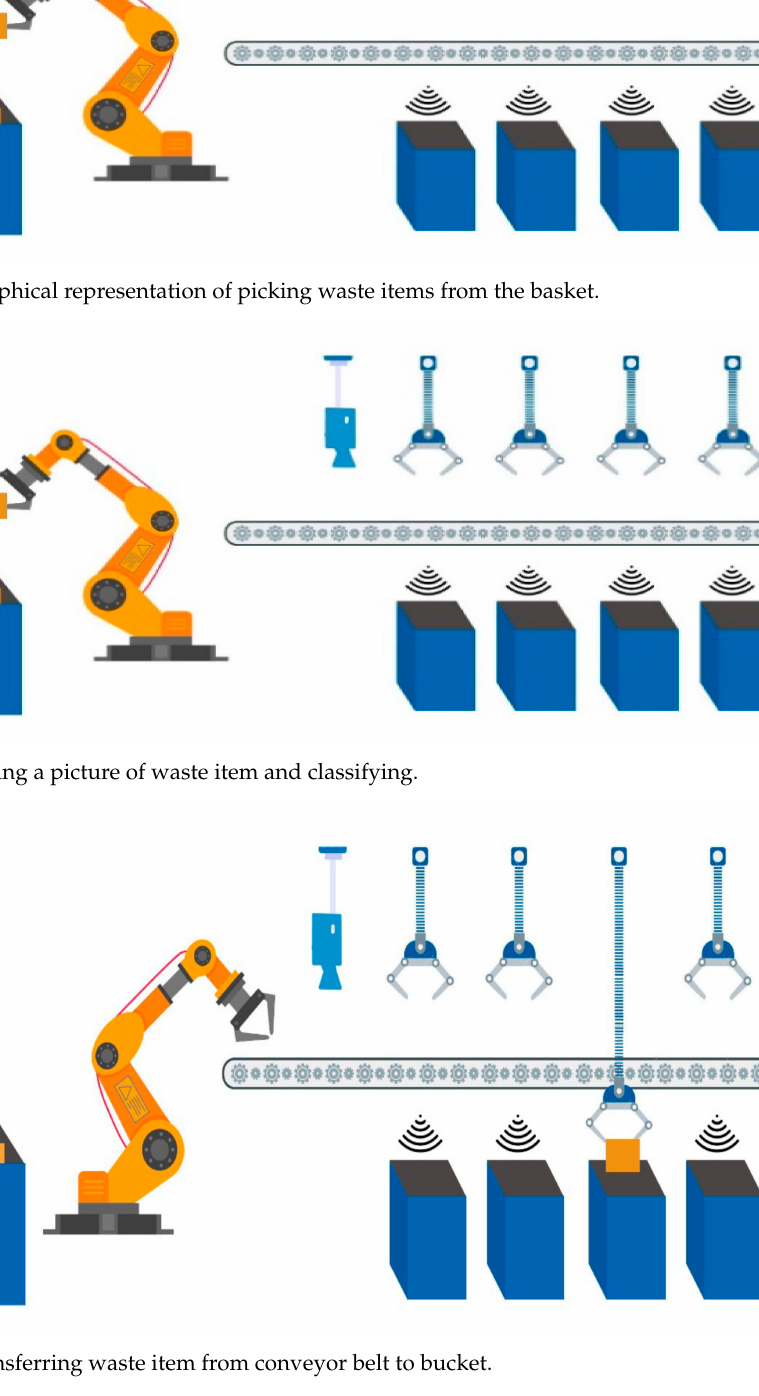
Figure 3. Transferring waste item from conveyor belt to